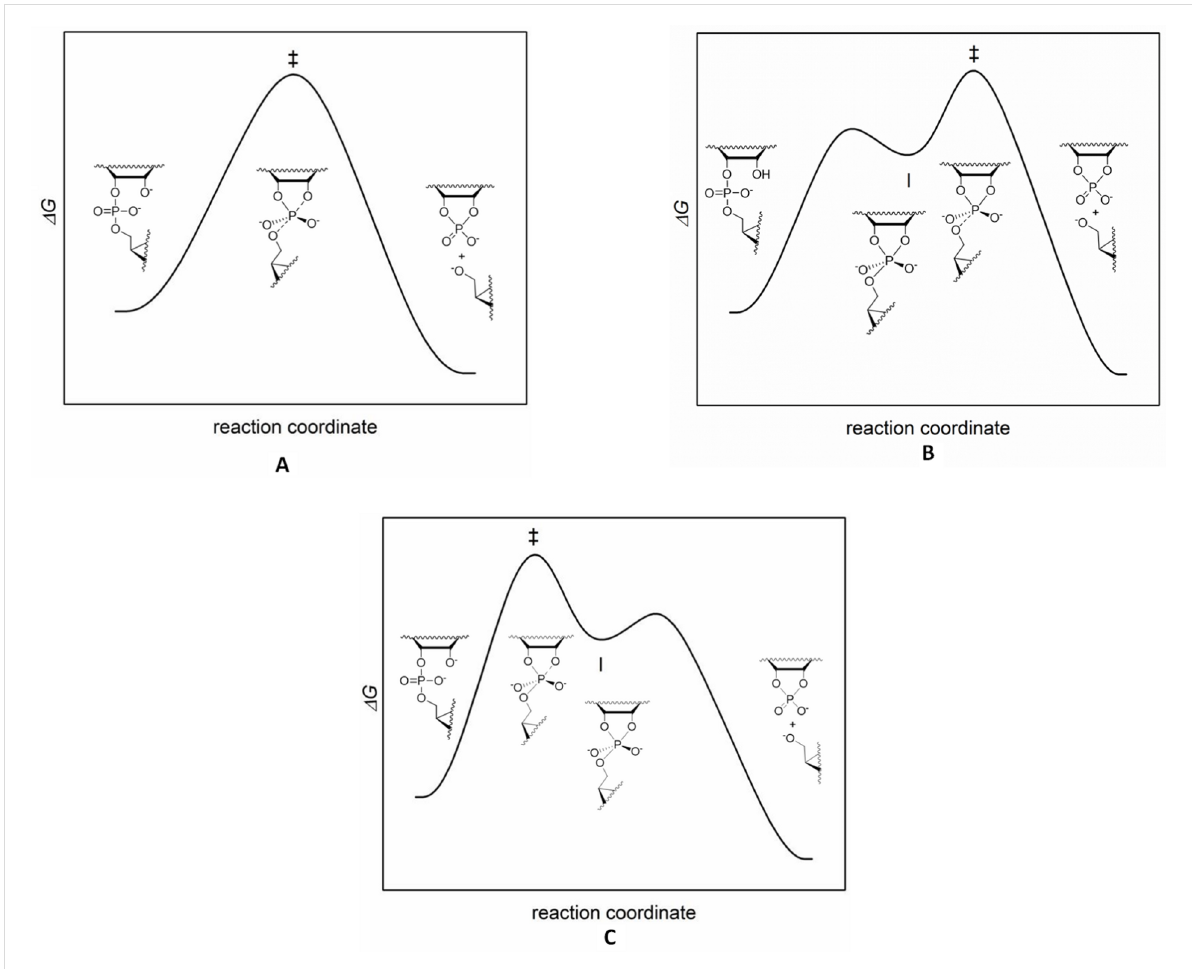
Figure 2: Energy profiles for a concerted A N D N (A) and stepwise mechanisms (A N + D N ) with rate-limiting breakdown (B) and rate-limiting formation (C) of intermediate I that has a finite life-time. Hydroxide-ion-catalyzed cleavage of RNA has been used to exemplify alternative mechanisms. In reality, the reaction takes place by rate-limiting breakdown of the intermediate